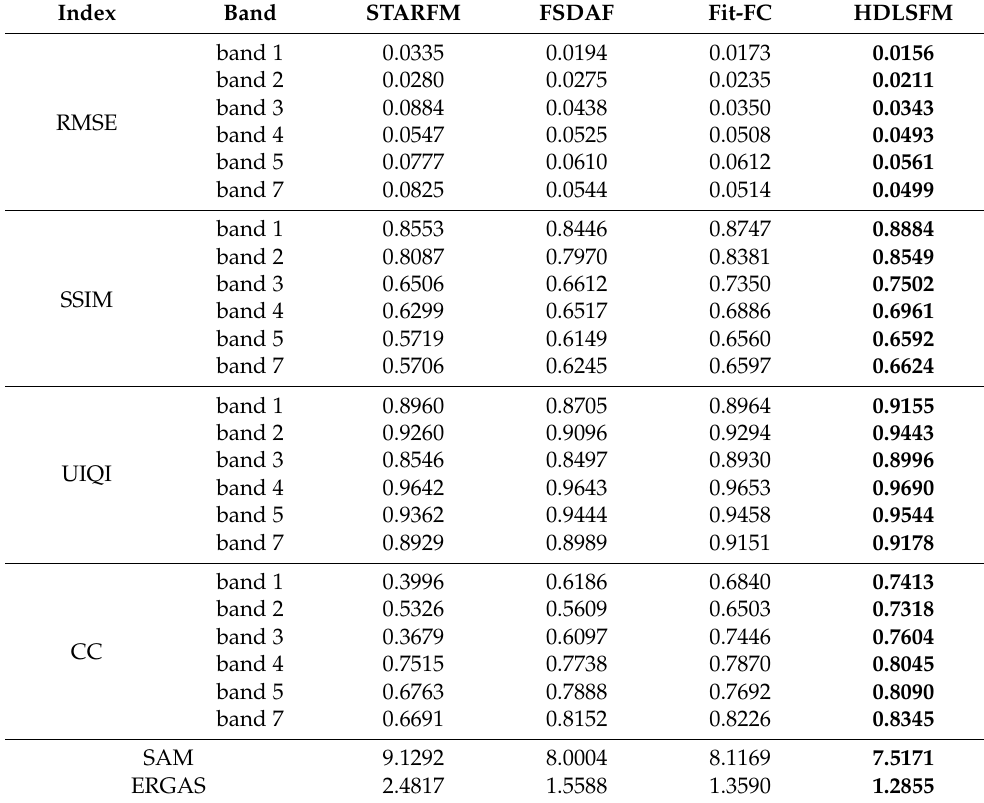
Table 4. Quantitative assessment of the prediction on 13 Feb 2002 of different STF methods in the sub-area of the CIA site. Bold values indicate best